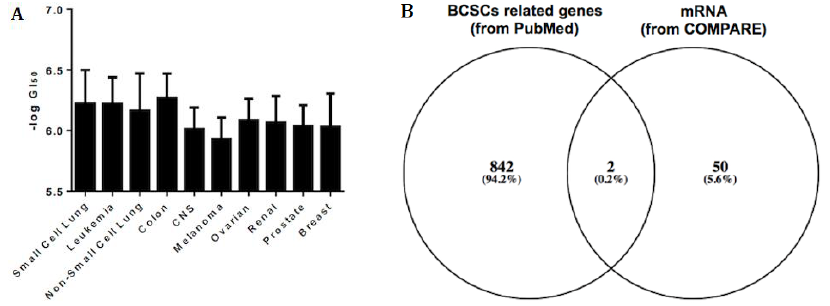
Figure 1. (A) Cytotoxic activity of ellipticine on NCI-60 cancer cells. Data were retrieved from the public library of COMPARE. (B) Venn diagram of BCSC regulatory genes and mRNA array analysis from